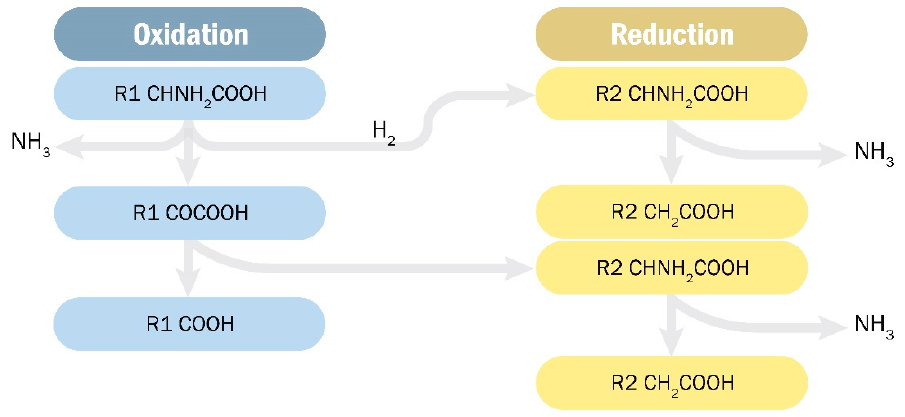
Figure 5. Schematic of the Stickland oxidation-reduction reaction.